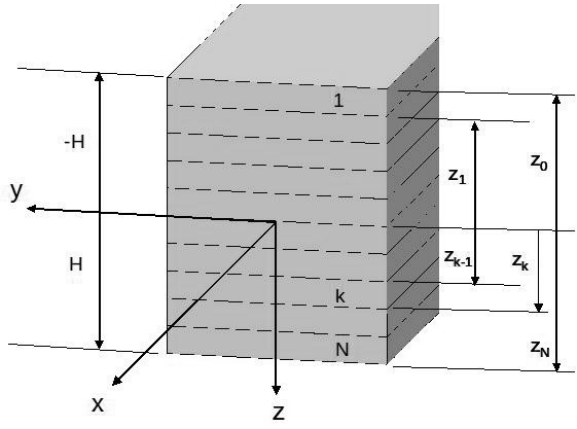
Figure 1: Configuration of composite layers